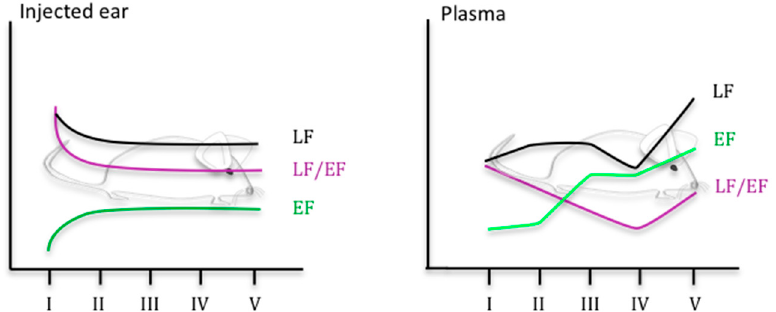
Figure 2. Kinetics of LF and EF level in a mouse model of cutaneous anthrax, adapted from [46] (stage I to V defined through BLI imaging. Stage I: no BLI, stage II: BLI in the injected ear; stage III: BLI in the injected ear and in the draining cLNs; BLI in the injected ear, in the draining cLNs and in the spleen; stage V: mice in septicemia).